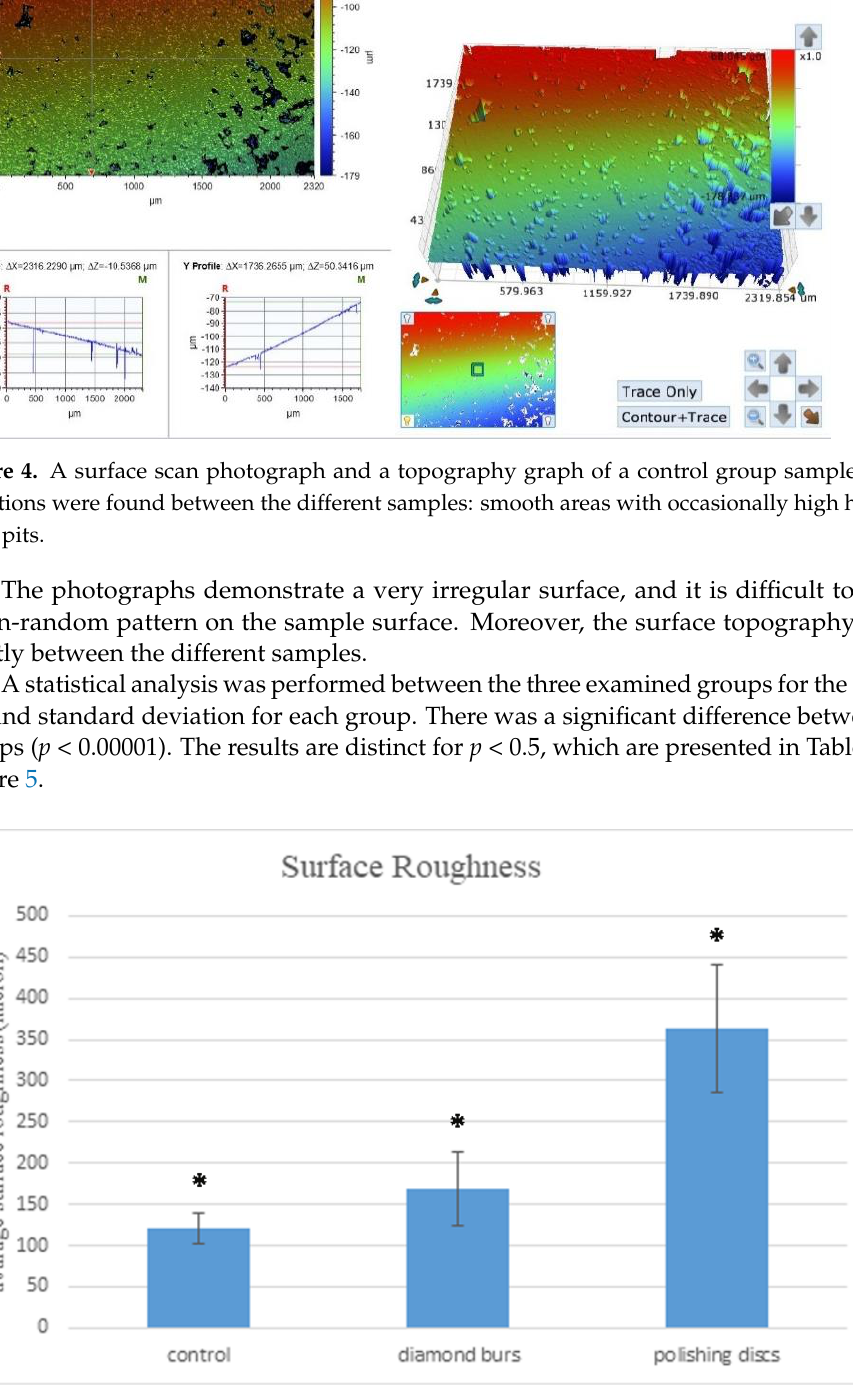
Figure 5. A surface RA comparison between the three test groups. A statistically significant difference was observed between the groups (* p < 0.00001).